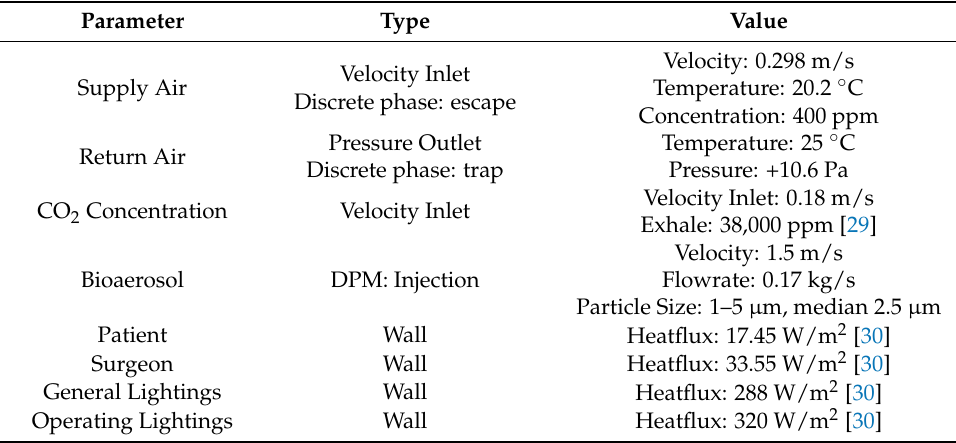
Table 2. The boundary condition for numerical simulations.